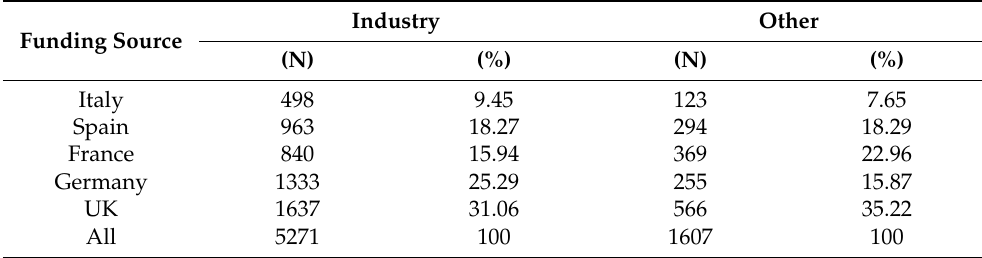
Table 1. Funding source of phase 1 clinical trials in EU. Five European countries were selected: France, Germany, Italy, Spain and the UK. The period from 1 January 2012 to 31 December 2021 was taken into